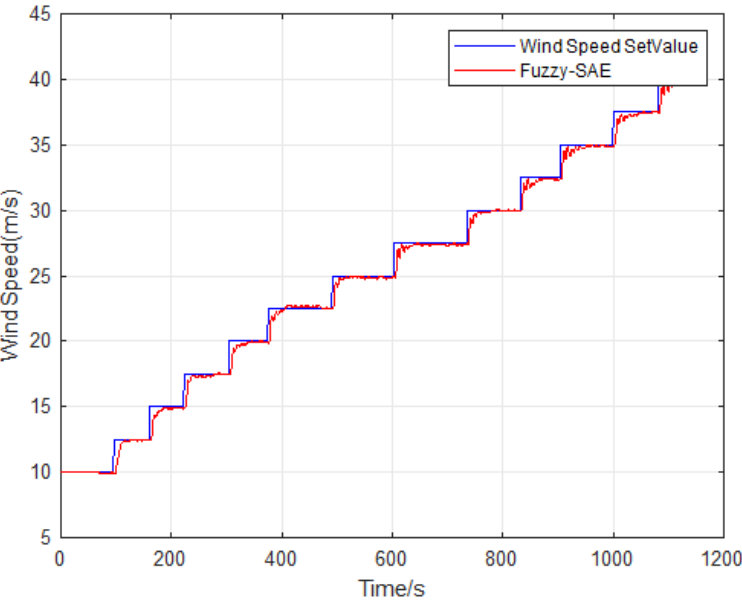
Figure 11. Using the fuzzy-SAE algorithm to test the wind speed curve of the variable Reynolds number.